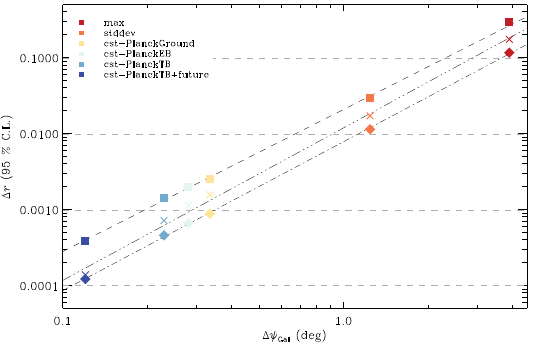
Figure 2. Likelihood posterior on r biases (with respect to an input signal of r = 0) for the di ff erent cases of combined calibration errors (presented in Sect. 3) from 10000 Monte-Carlo simulations, as a function of the combined error on the angle ∆ ψ Gal in degrees. They are computed independently for the recombination bump (30 < (cid:31) < 300, squares), the reionisation bump (2 < (cid:31) < 30, diamonds) and the combination of both (2 < (cid:31) < 300,